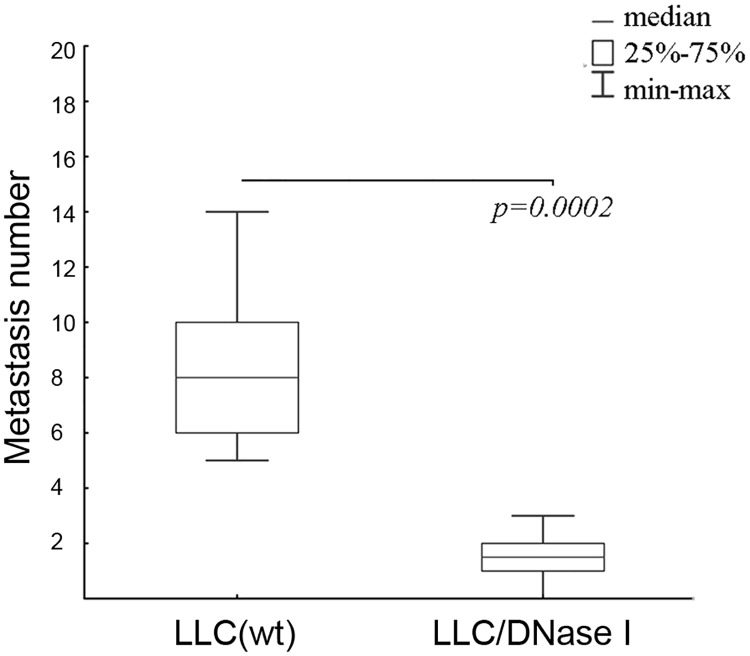
Number of metastases in lungs of mice with LLC treated with saline buffer (LLC(wt)) or DNase I (LLC/DNase I).LLC cells were injected intramuscularly (i.m.) into C57Bl/6J mice (n = 10). On day 4 after LLC cells inoculation the mice were daily intramuscularly treated with DNase I (0.12 mg/kg). Data are presented as mean ± SEM. Statistical significance is p < 0.0002.